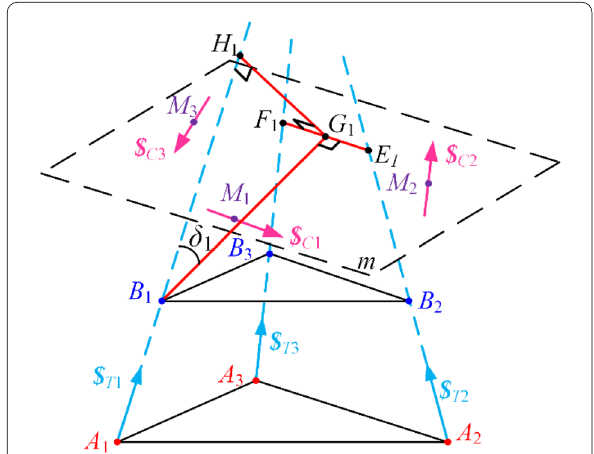
Figure 4 Calculation for